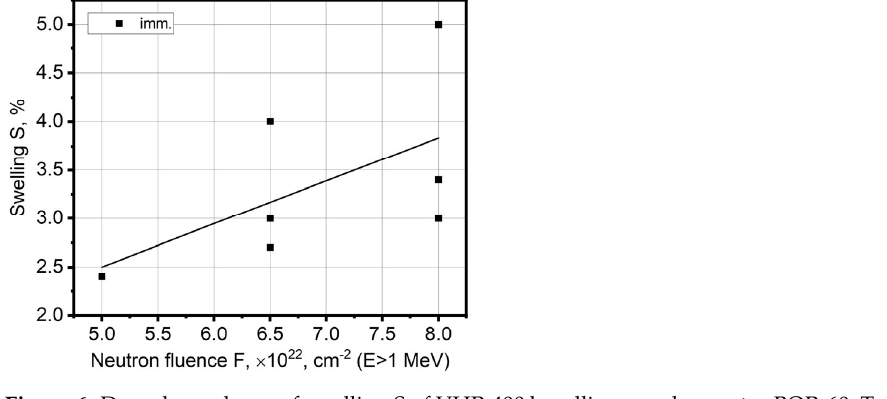
Figure 6. Dose dependence of swelling S of VHP-400 beryllium grade, reactor BOR-60, T irr = 420 ◦ C, F = (5–8) · 10 22 cm − 2 (E > 1 MeV) (imm.—immersion).